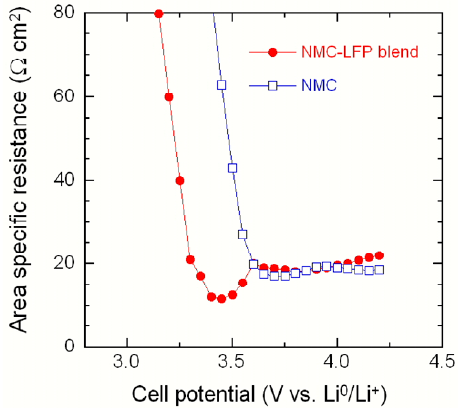
Figure 12. Plot of the area specific resistance of NMC and NMC–LFP blend as a function of the cell potential showing the increase in area specific resistance (ASR) at low state of charge (SOC).